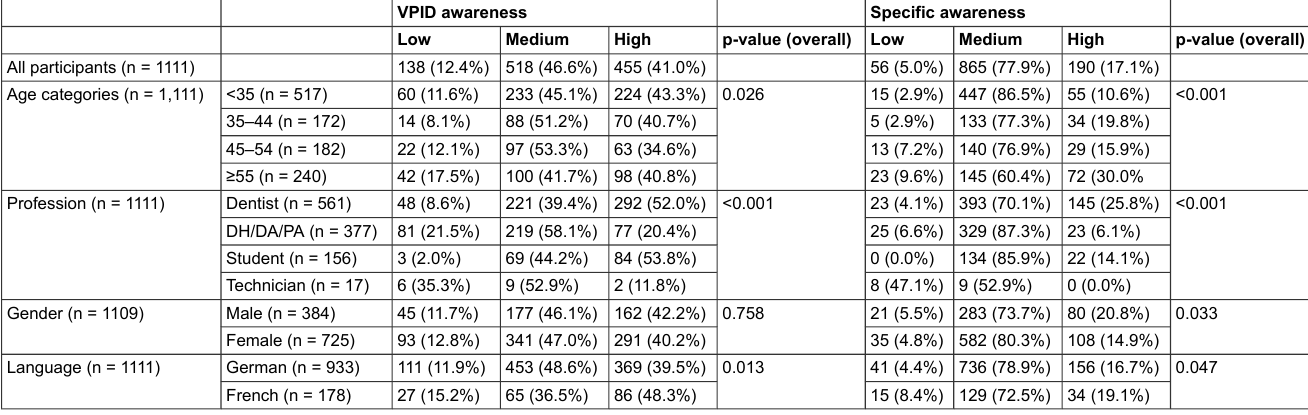
Table 5: Level of awareness related to vaccinations overall and for different age categories, profession, gender, and language.